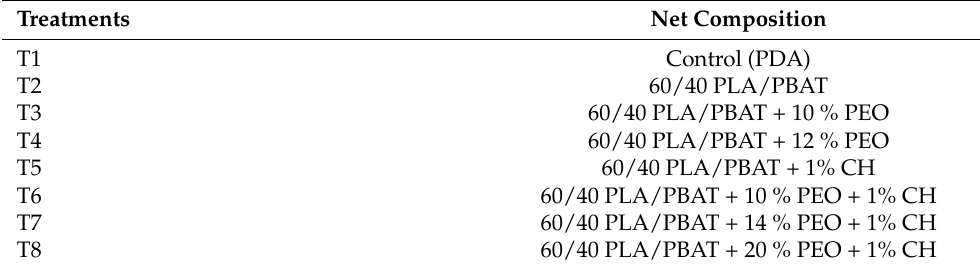
Table 4. Formulations for the manufacturing of polymeric nets for in vitro and in situ treatments.